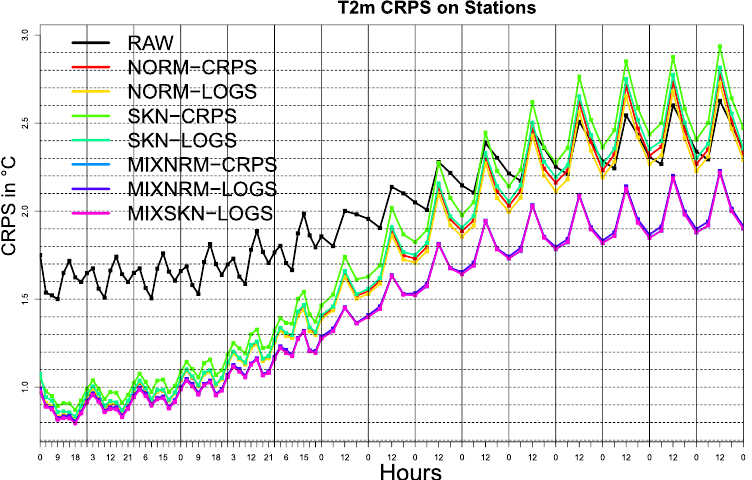
Figure 4. Average CRPS on 3 years/2056 stations along lead times. The three MIX models are very close together and have the best CRPS averages, especially from Day